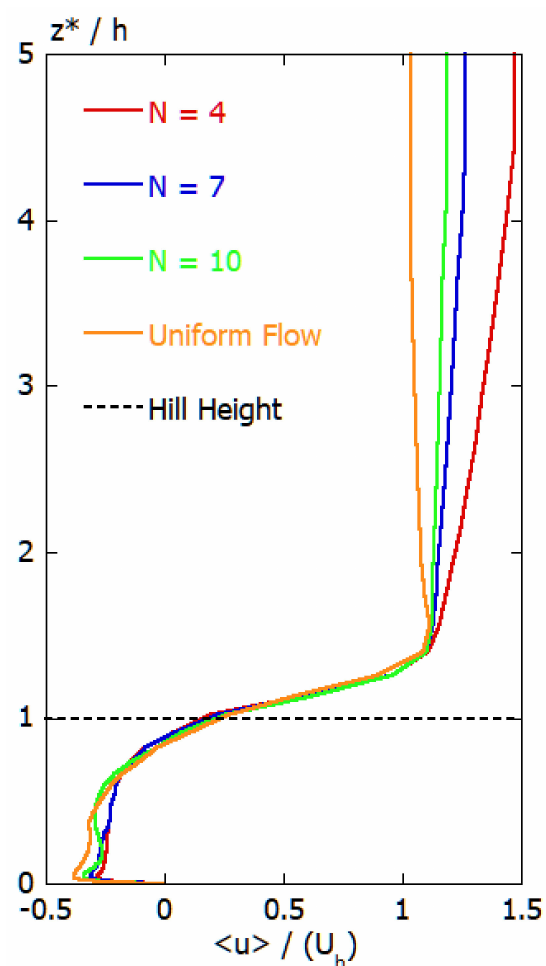
Figure 8. Comparison of a time-averaged U-velocities at a measurement station (x = 2 h) behind the steep hill under various inflow